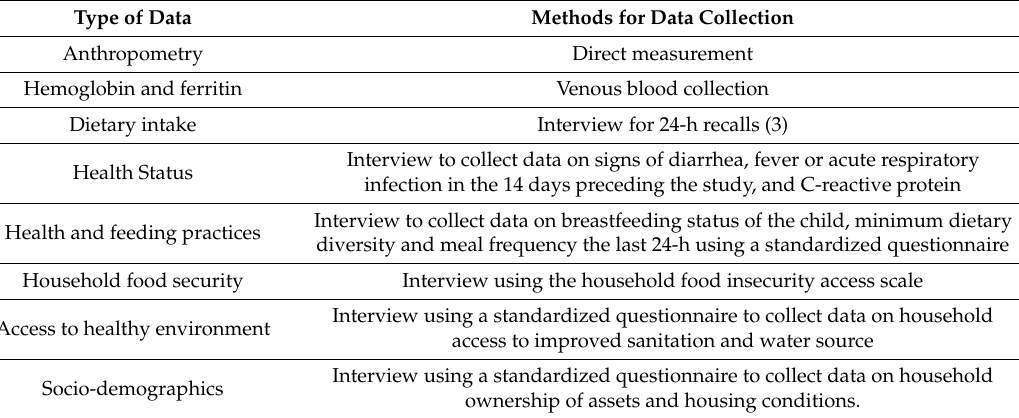
Table 1. Summary of the data collected and methods